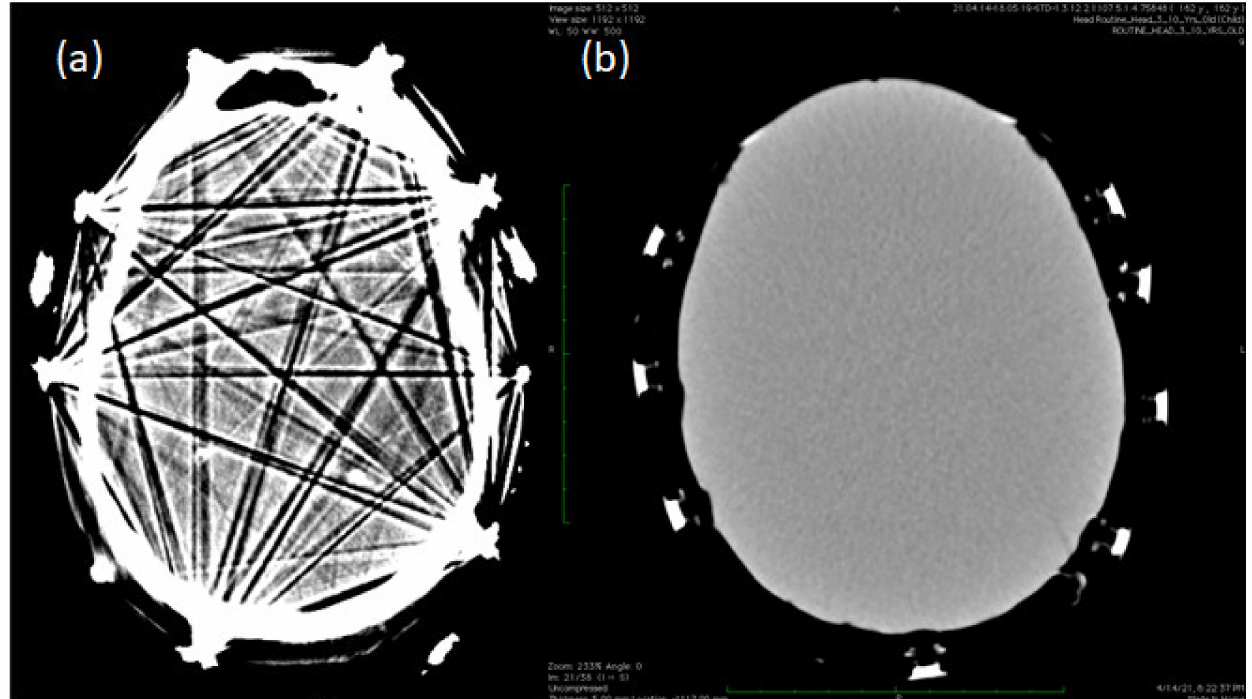
Figure 8. Axial CT images with conventional EEG electrodes (left) vs. Neo-Net EEG (right). ( a ) Axial view of a patient with artifacts from EEG electrodes. ( b ) Images with the NeoNet without noticeable artifacts from electrodes inside the phantom. In both cases, similar display settings were used for the window-width and